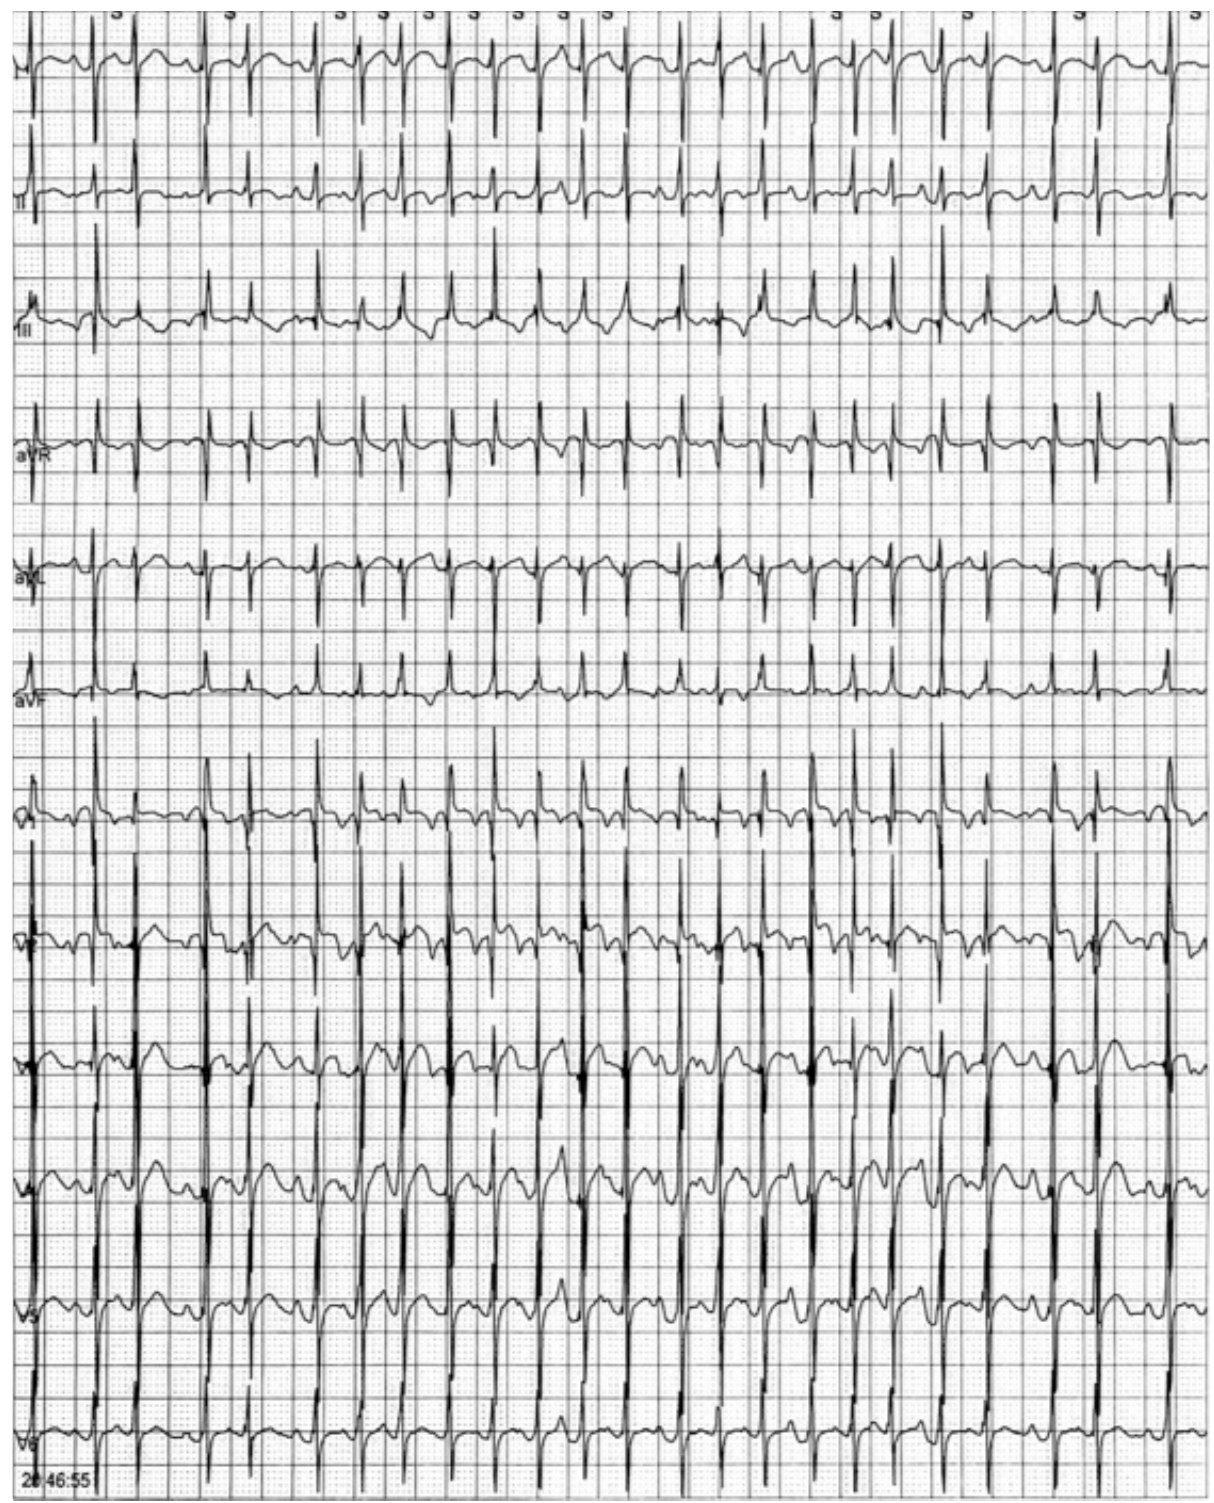
Figure 1. ECG Holter monitoring showing an episode of multifocal atrial tachycardia. Ultrasound lung scan performed after admission detected significant foci of lung consolidation with air bronchogram, involving basal fields bilaterally and medium fields